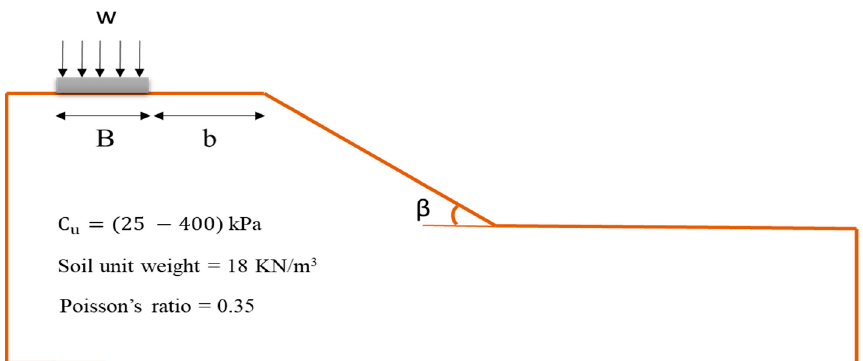
Figure 1. A view of the geometry of the slope.